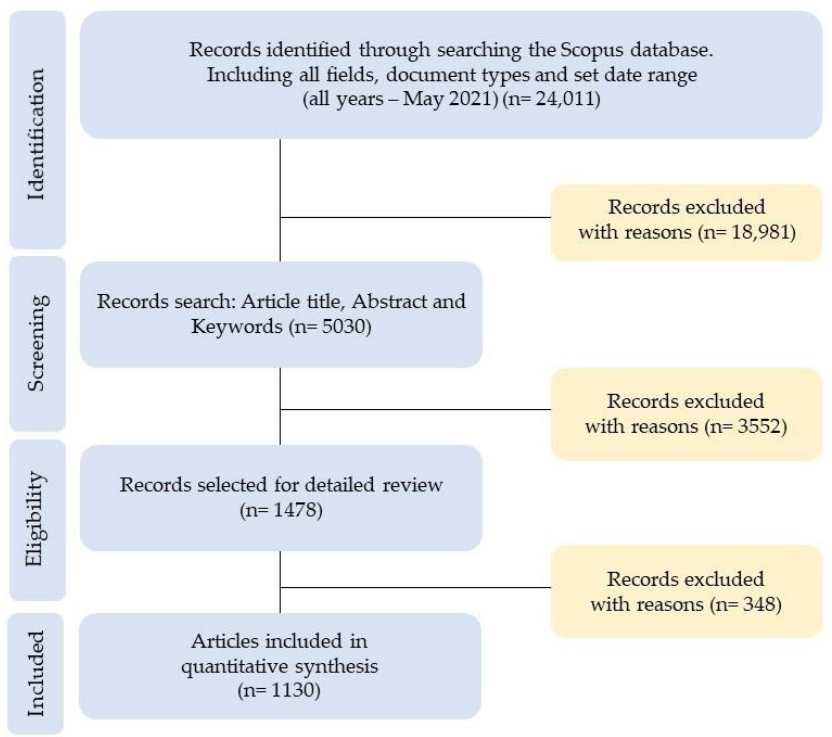
Figure 1. Record inclusion/exclusion flowchart (based on PRISMA).